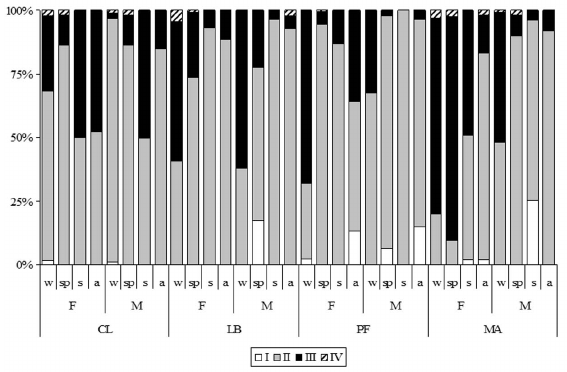
Fig . 3. – Percentage of individual of C. linguatula (CL), L. boscii (LB), P. flesus (PF) and M. azevia (MA) in each maturation stage (I, Immature; II, Development; III, Spawning; IV, Post-spawning), according to season (w, winter; sp, spring; s, summer; a, autumn) and to sex (F, females; M,